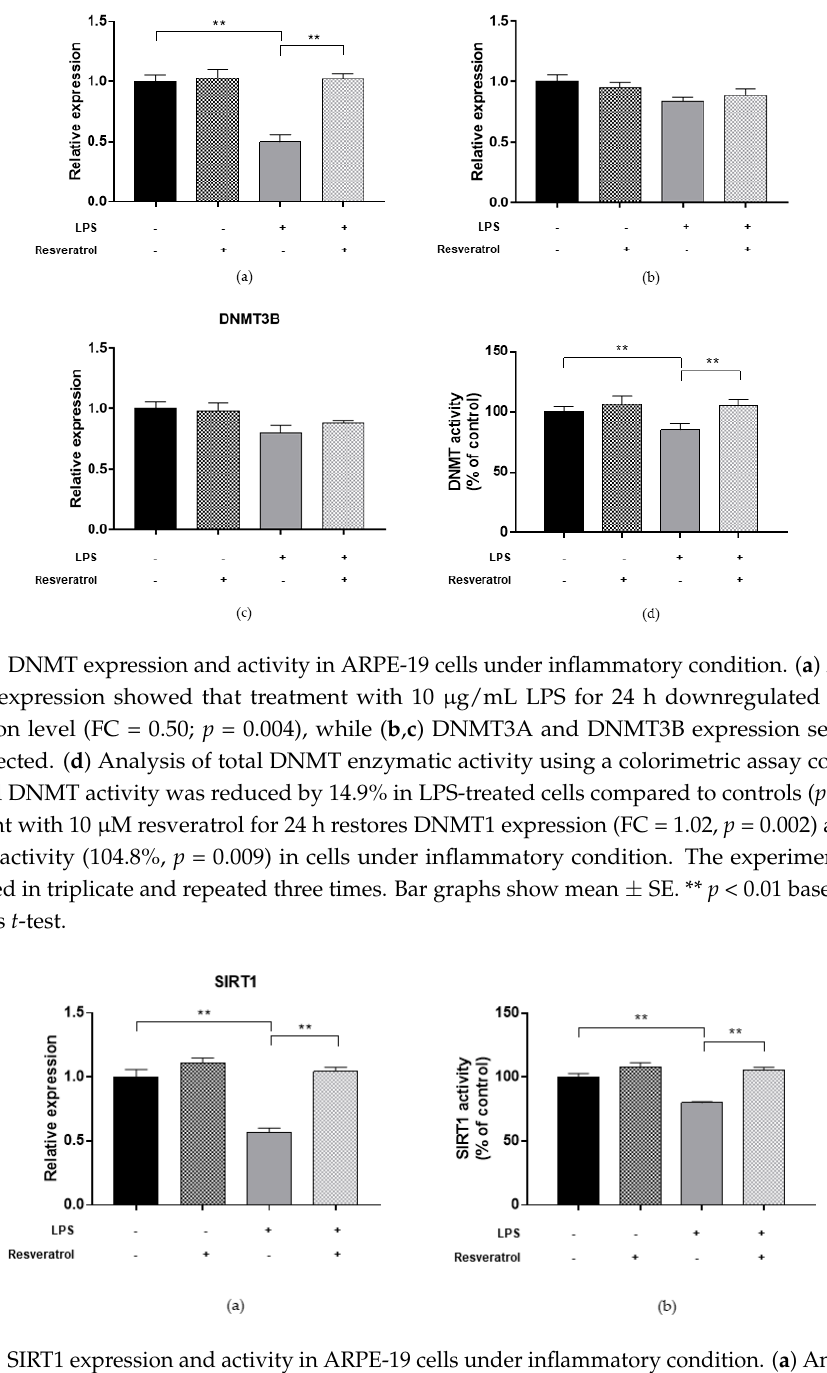
Figure 6. SIRT1 expression and activity in ARPE-19 cells under inflammatory condition. ( a ) Analysis of gene expression showed that treatment with 10 µg/mL LPS for 24 h downregulated SIRT1 expression level (FC = 0.57; p = 0.003). ( b ) Analysis of SIRT1 enzymatic activity using a fluorimetric assay confirmed that total SIRT1 activity was reduced by 20.1% in LPS-treated cells compared to controls ( p = 0.002). Treatment with 10 µM resveratrol for 24 h restores SIRT1 expression (FC = 1.04, p = 0.009) and activity (105.5%, p = 0.005) in cells under inflammatory condition. The experiments were performed in triplicate and repeated three times. Bar graphs show mean ± SE. ** p < 0.01 based on the Student’s t -test.